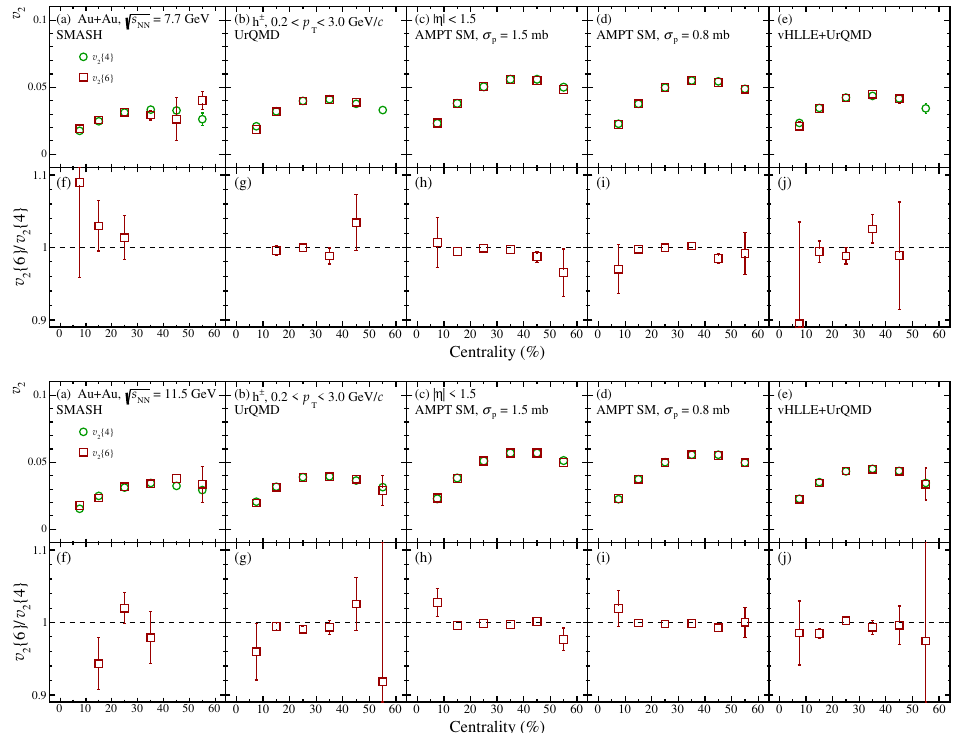
Figure 7. Centrality dependence of v 2 of inclusive charged hadrons from Au+Au collisions at √ s NN = 7.7 and 11.5 GeV obtained using the high-order Q -cumulants v 2 { 4 } , v 2 { 6 } methods in different models ( a – e ). Panels ( f – j ) show the ratio v 2 { 6 } / v 2 { 4 } . UrQMD, Au+Au, 10-40%, reconstructed (GEANT4)